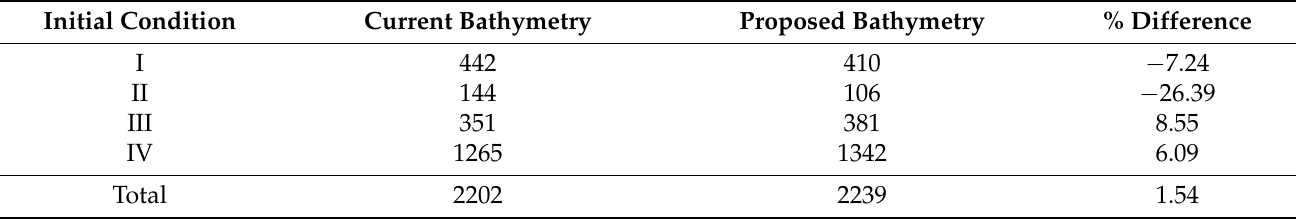
Table 1. Successful larvae count for 2012